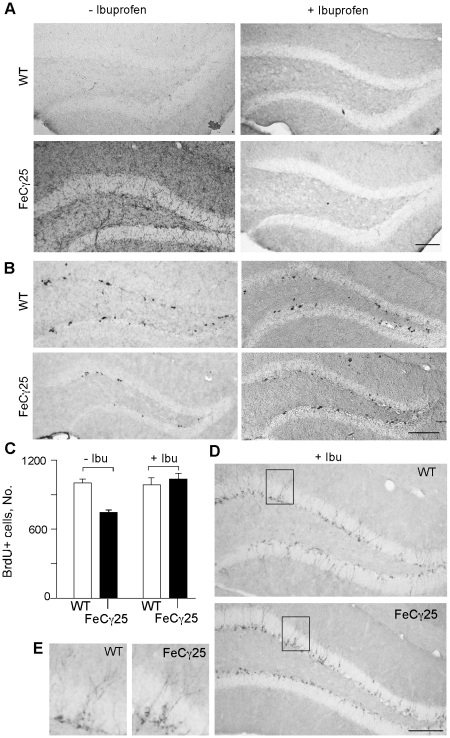
Non-steroidal anti-inflammatory drug (NSAID; ibuprofen) treatment rescued impaired adult hippocampal neurogenesis in FeCγ25 mice.
A, CD-45 immunohistochemistry showed that ibuprofen treatment for 2 months (right) can decrease neuroinflammation seen in FeCγ25 mice compared to wild-type (WT) mice (left) at 3 months of age. B–C, Ibuprofen treatment rescued decreased adult hippocampal cell proliferation in FeCγ25 mice at 3 months, quantified in C. D–E, The number of immature neurons detected by doublecortin immunoreactivity was also increased in FeCγ25 mice (bottom) compared to wild-type mice (top) after ibuprofen treatment. Comparable hippocampal regions are identified in box D and enlarged in E for wild-type (left) and FeCγ25 mice (right). Error bars represent S.E.M. Scale bar  = 100 µm. n = 4 for untreated wild-type and FeCγ25 mice and n = 3 and 4 for ibuprofen treated wild-type and FeCγ25 mice respectively.